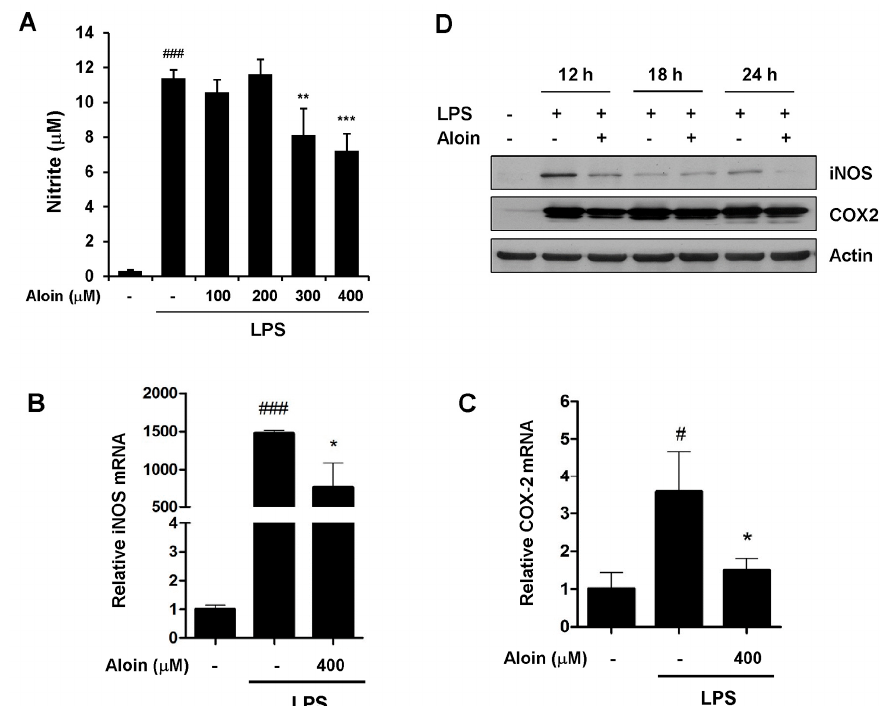
Figure 3. Aloin inhibits nitric oxide (NO) production and the expression of cyclooxygenase-2 (COX-2) and inducible nitric oxide synthase (iNOS). ( A ) RAW 264.7 cells were pre-treated with aloin for 2 h prior to LPS (100 ng/mL) treatment. Cell-free supernatants were collected to determine NO production using the Griess reaction after LPS treatment for 24 h. The mRNA levels of ( B ) iNOS and ( C ) COX2 were determined by qPCR; ( D ) RAW 264.7 cells were pre-treated with or without 400 µ M aloin for 2 h, and then stimulated with LPS (100 ng/mL) for 12 h, 18 h and 24 h. Levels of iNOS and COX-2 proteins were determined by Western blotting. The results shown are the means ± SD of three experiments. # p < 0.05 and ### p < 0.001 are significantly different from the control. * p < 0.05, ** p < 0.01, and *** p < 0.001 are different from the LPS alone.